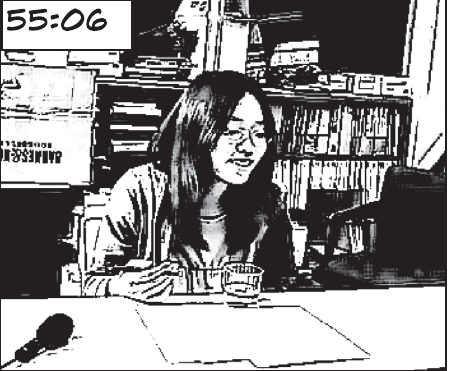
FIG. 7. Judy displays positive emotion in facial expressions after successfully solving the conceptual problem on waveforms and their RMS voltage.